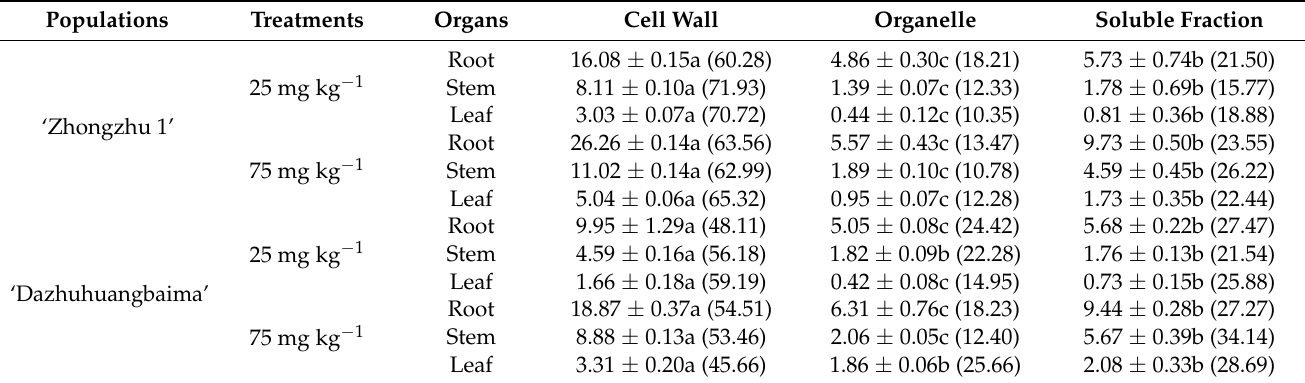
Table 1. Subcellular Cd (mg kg − 1 DW) distribution in different organs of two ramie